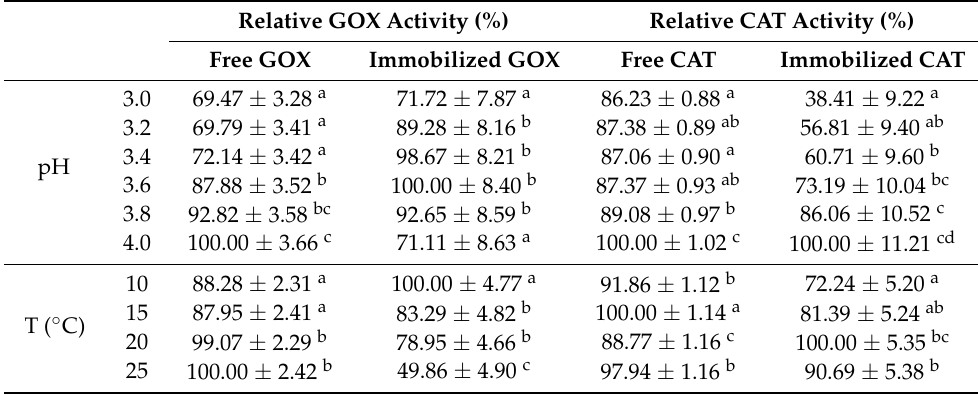
Table 2. Effect of pH and temperature (T) on free and immobilized GOX and CAT activity. Relative GOX Activity